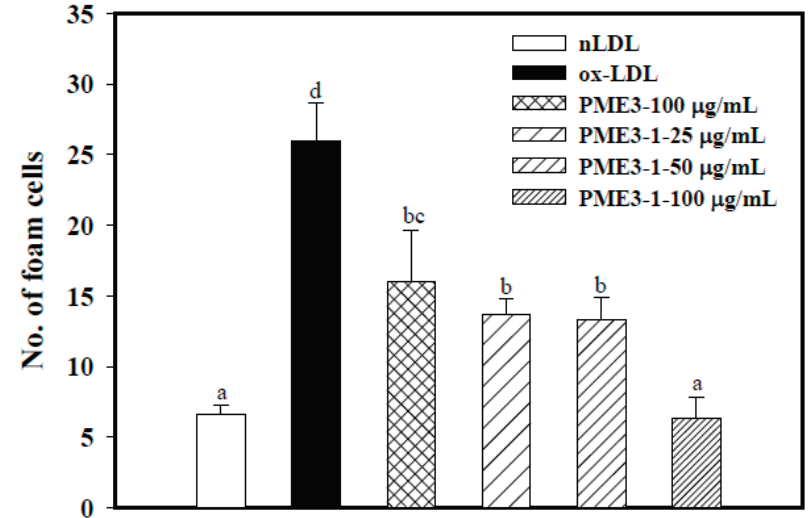
Figure 5. Inhibitory effects of PME3-1 on foam cell formation in RAW 264.7 macrophages induced by oxidized-LDL. ox-LDL was induced by the addition of CuSO 4 (10 μ M) to n-LDL (100 μ g/mL) at 37 °C for 24 h. Then, ox-LDL (or n-LDL), PME3, or PME3-1 was co-incubated with macrophages for 24 h. Data are expressed as means ± SD of three separate experiments. Values not sharing an alphabetic letter are significantly different ( p <